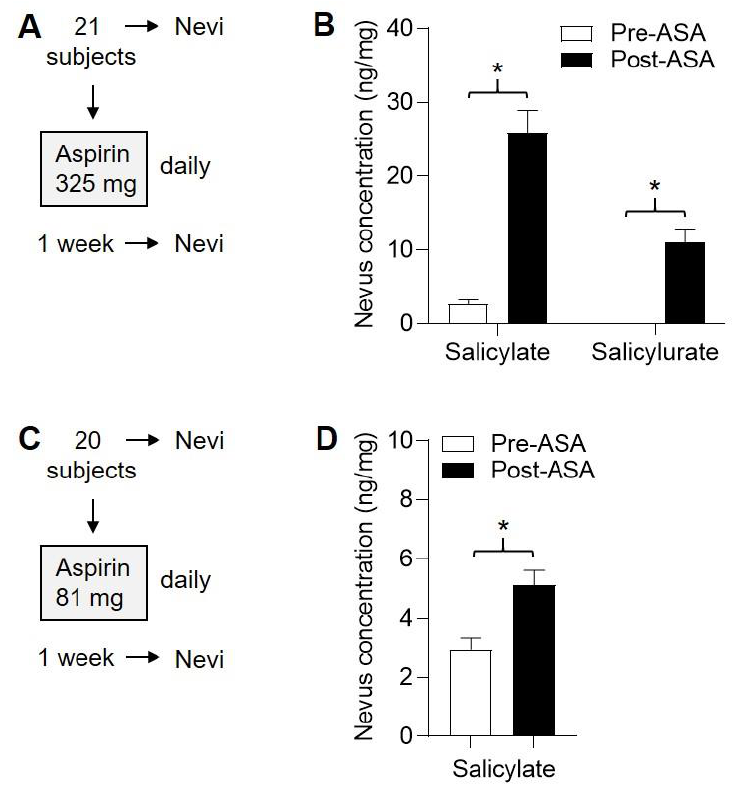
Figure 5. Detection of ASA metabolites in nevi following 1 week of daily ASA exposure. Human subjects were each given ASA daily for one week, and nevi were obtained both before (pre) and after (post) this period. ( A ), Protocol for 325 mg dosing. ( B ), Levels of salicylate and salicylurate in nevi in the 325 mg cohort. * p < 0.0001, paired t -test. ( C ), Protocol for 81 mg dosing. ( D ), Levels of salicylate and salicylurate in nevi in the 81 mg cohort. * p < 0.01, paired t -test. Salicylurate was detected in nevi of only two subjects from the 81 mg cohort (not shown). Gentisic acid and salicyl acyl glucuronide were not detected in any of the nevi.